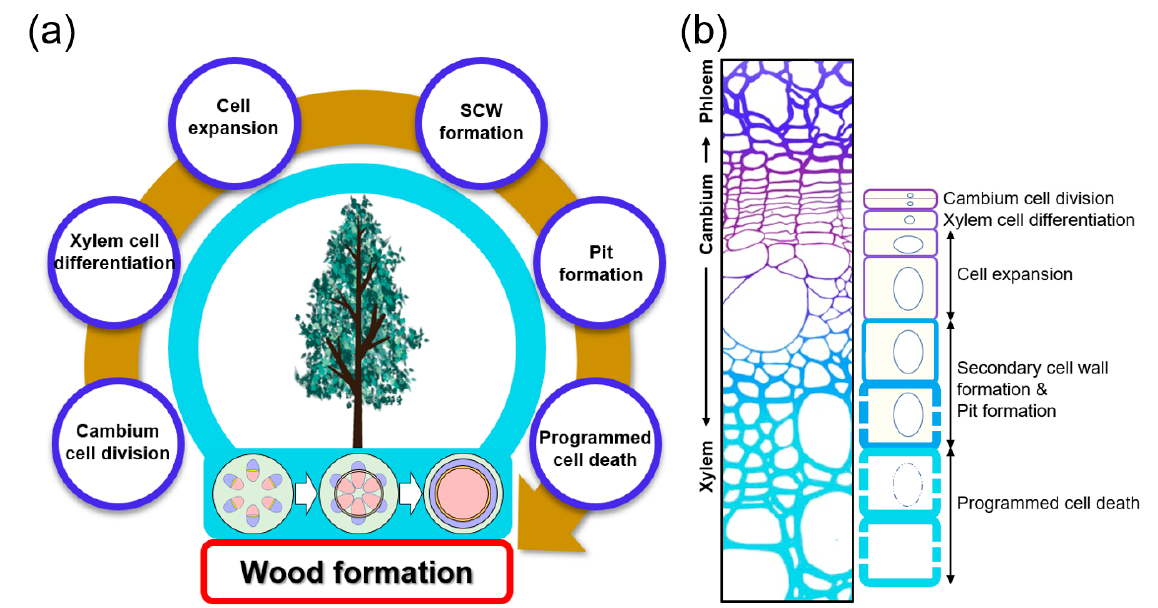
Figure 1. Wood formation in plants. ( a ) Simplified process of wood formation. Wood formation is initiated through cell divisions within the cylindrical vascular cambium layer, formed from the procambium. Then xylem cell differentiation, cell expansion, secondary cell wall (SCW) and pit formation, and programmed cell death (PCD) follow. Vascular cambium formation from procambium is shown in the stem cross-sections from below a tree: xylem (red), phloem (blue), and the cambium (yellow). ( b ) Stem cross-section and cell diagram for each stage of wood formation. The xylem is formed through the vascular cambium cell division and xylem cell differentiation, cell expansion, secondary cell wall formation and pit formation, and programmed cell death.